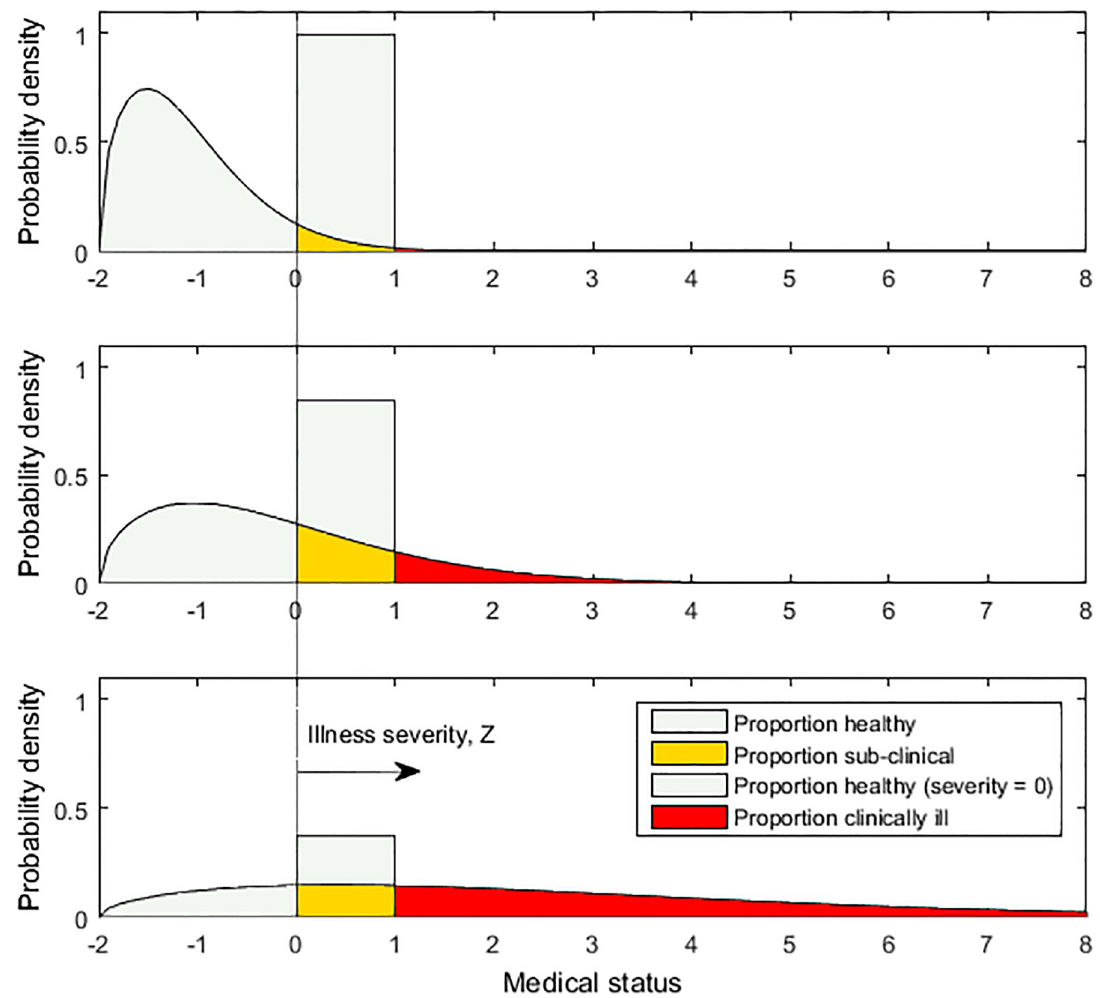
Fig 2. Diagram illustrating hypothetical illness severity distributions for three arbitrary doses, increasing from top panel to bottom panel. The three PDFs comprise distributions of numerical medical status (e.g., blood pressure), censored at the clinically- defined lower bound of health impairment, and thus having a monotonically-decreasing shape. The value of population response that would be indicated on a DRF, for a given dose, is the area (red or dark grey) under the illness severity distribution for that dose, integrated over the range of illness severity considered to represent the desired illness